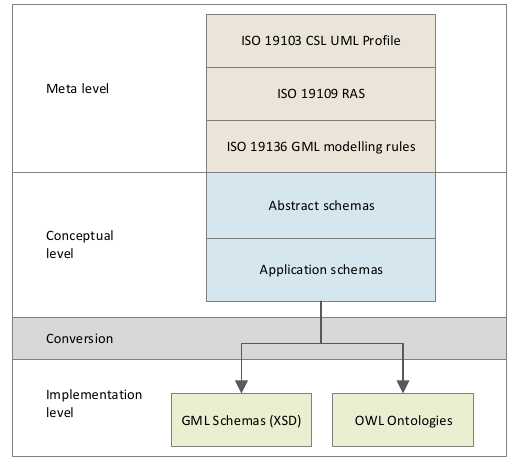
Figure 2. The use of Model-Driven Architecture in